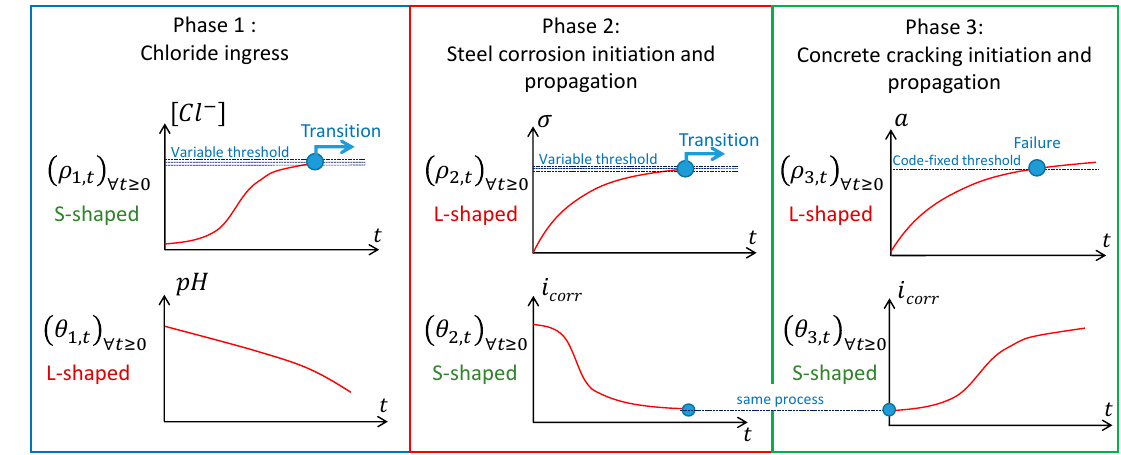
Figure 1. Mean tendencies of the physical indicators for the three phases.